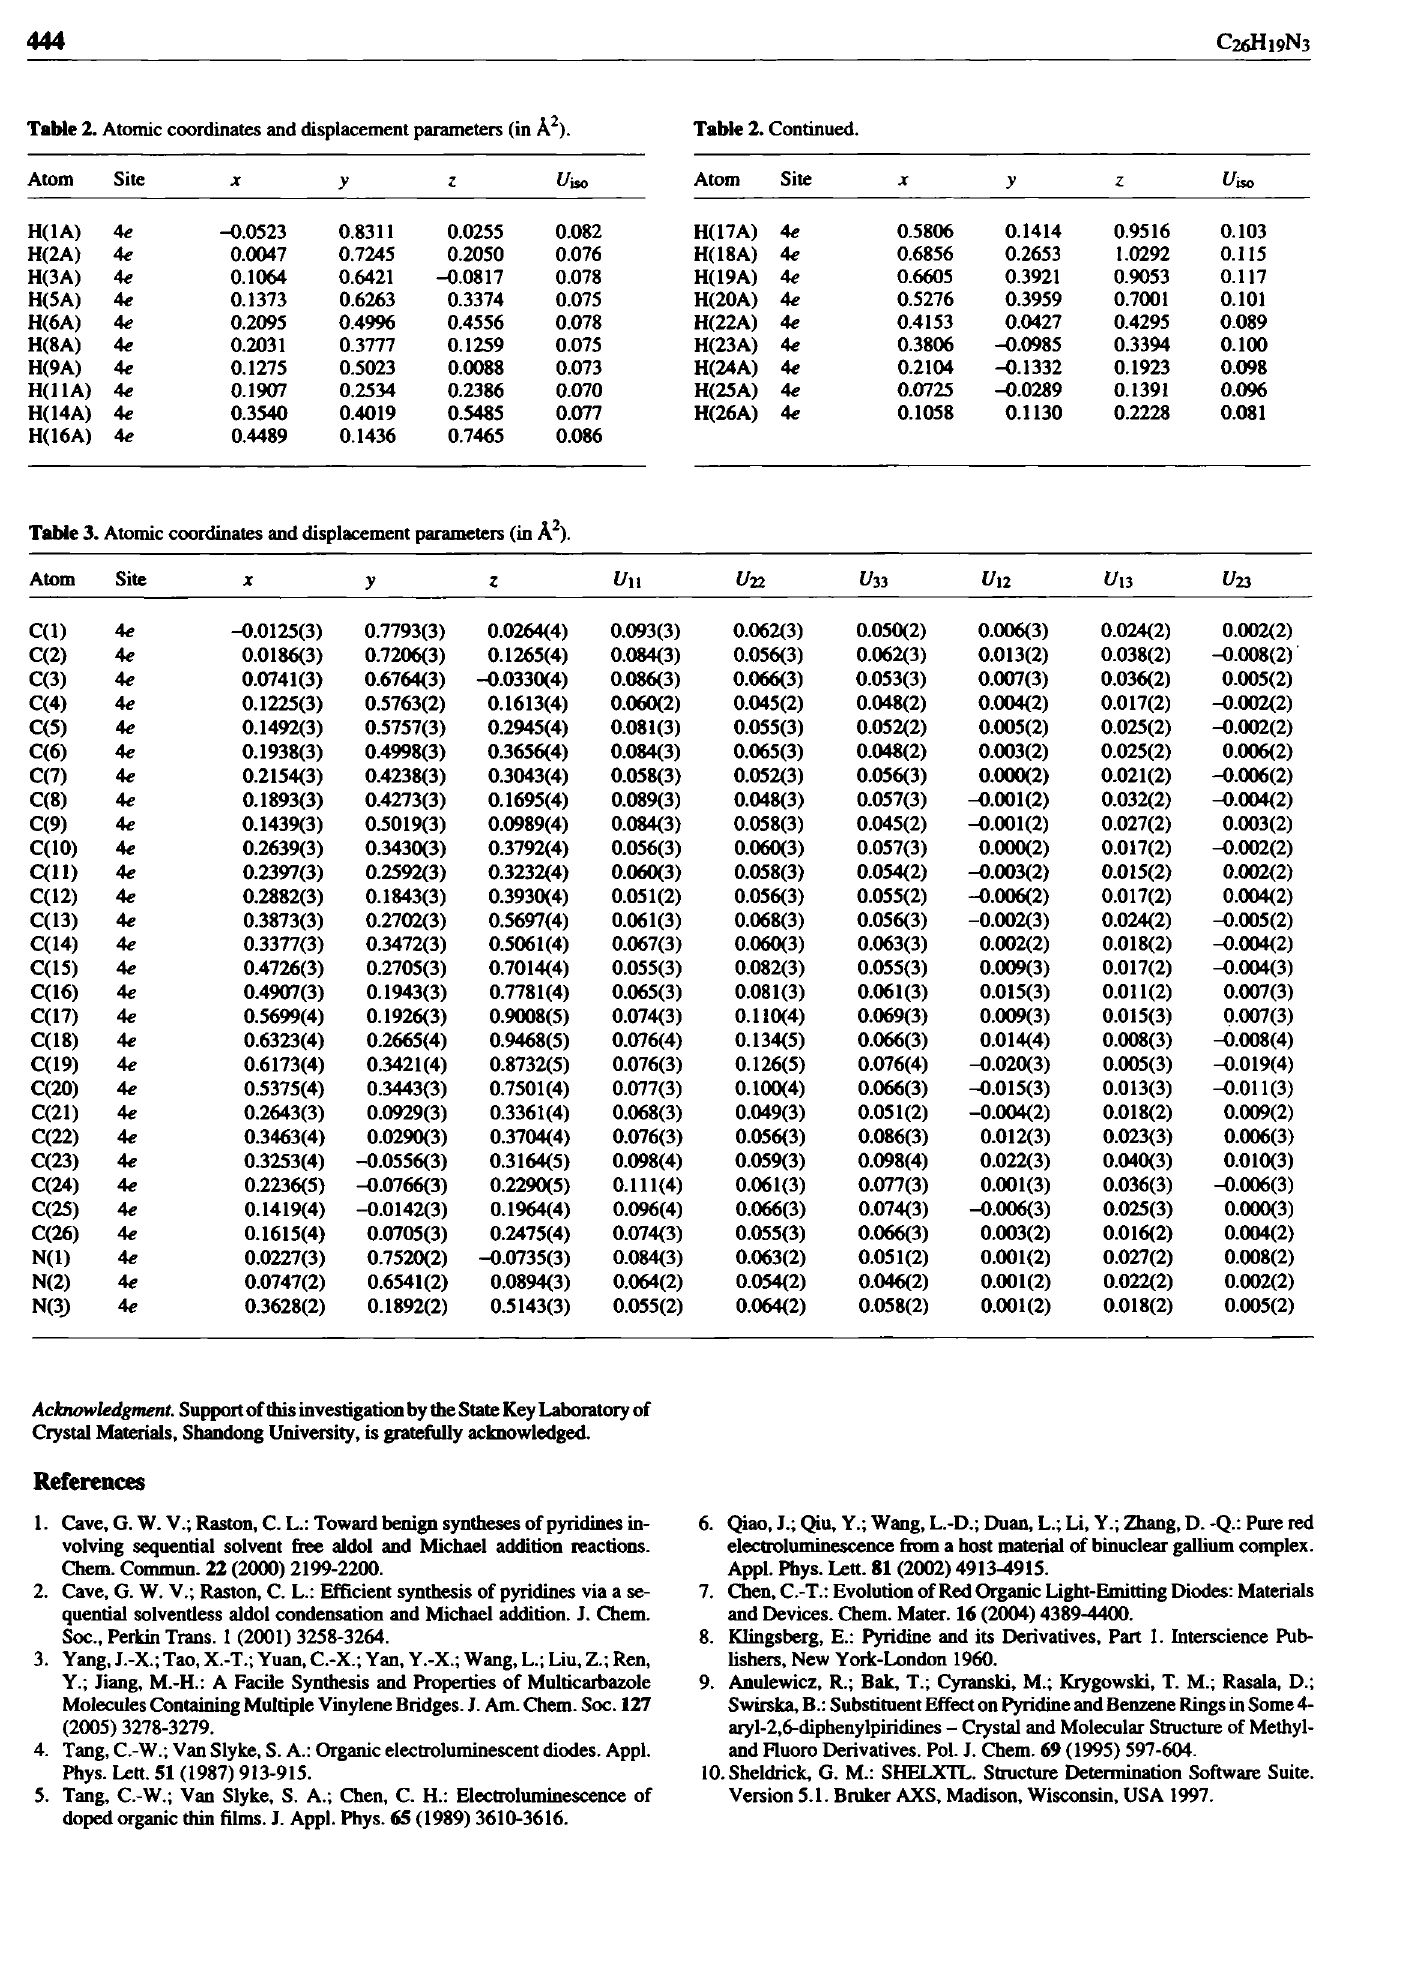
Table 3. Atomic coordinates and displacement parameters (in A 2